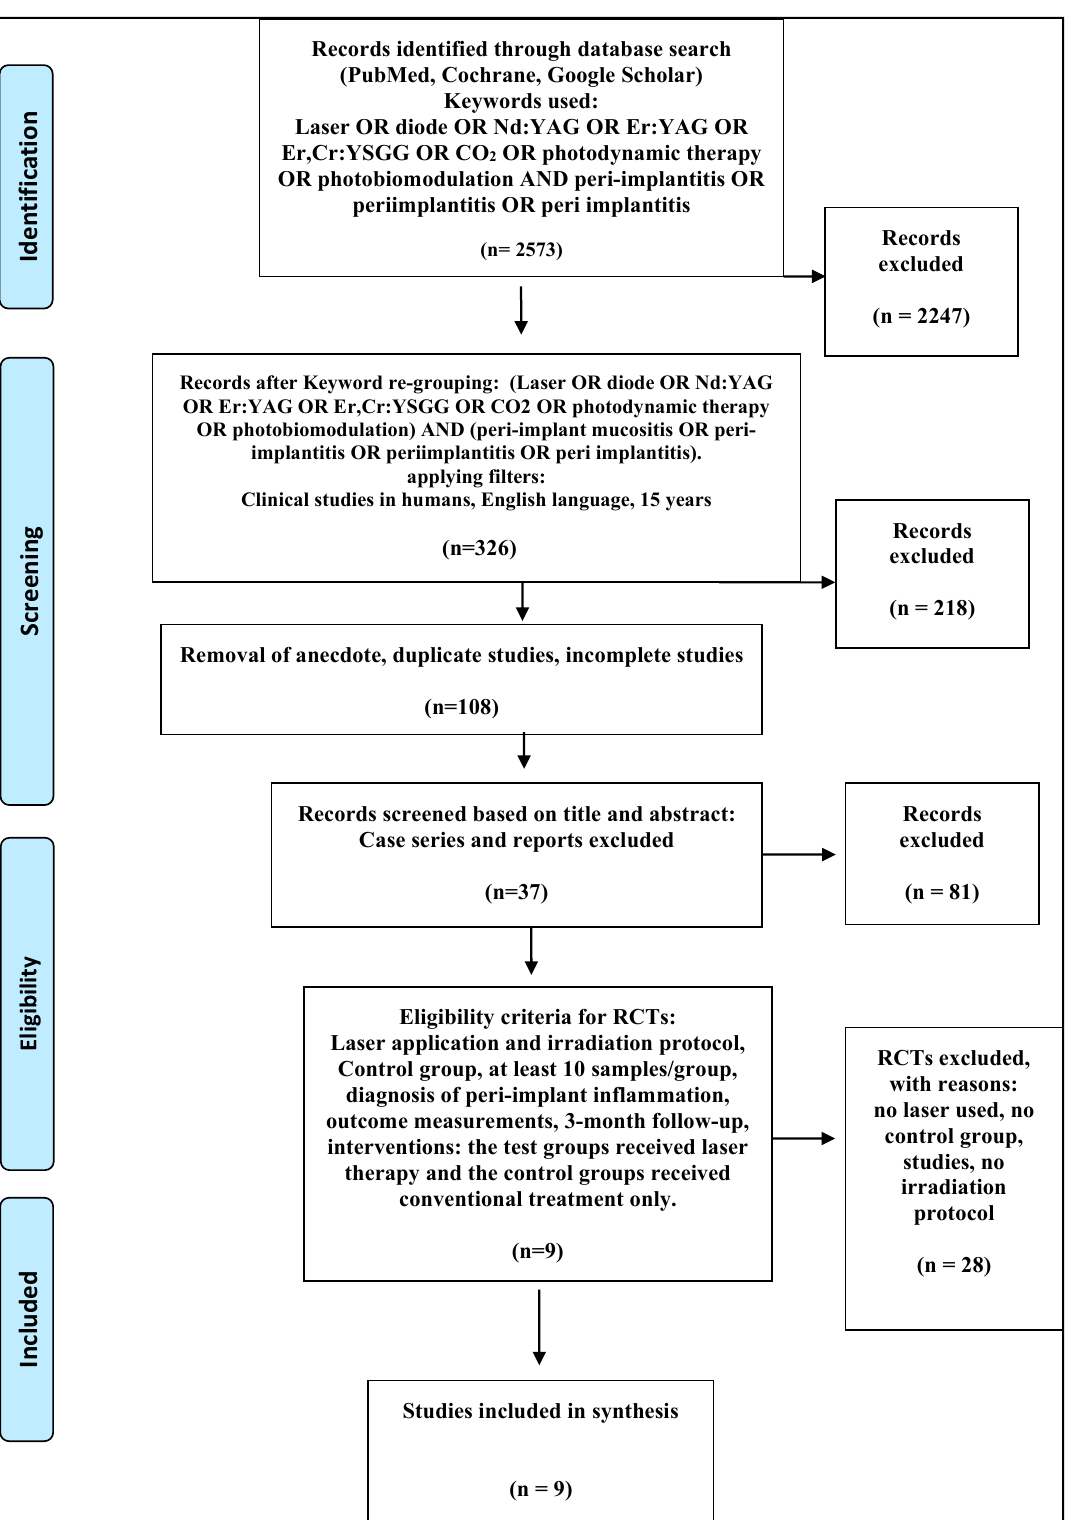
Figure 1. PRISMA flow-chart - selected criteria for the included studies.